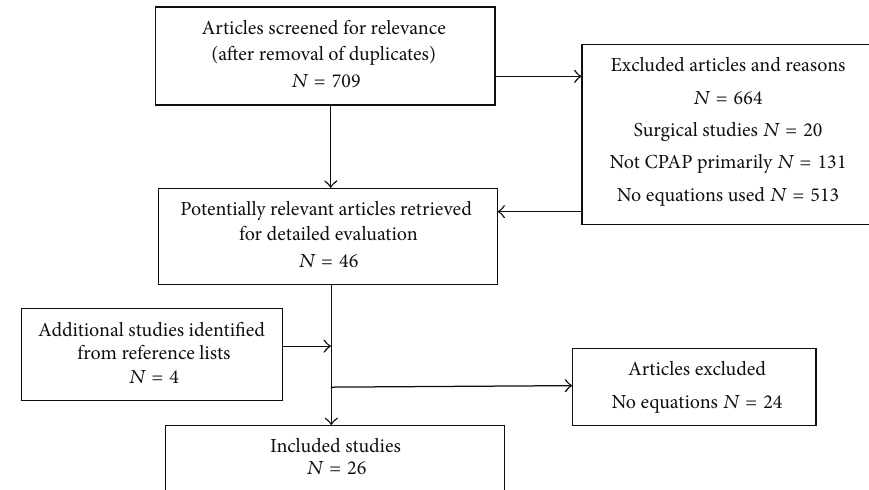
Figure 1: Flow diagram for studies reporting mathematical equations for predicting positive airway pressures. 𝑁 = number of articles. published their predictive equations: Britain, Canada, China, Germany, Greece, Japan, Korea, Mexico, Taiwan,